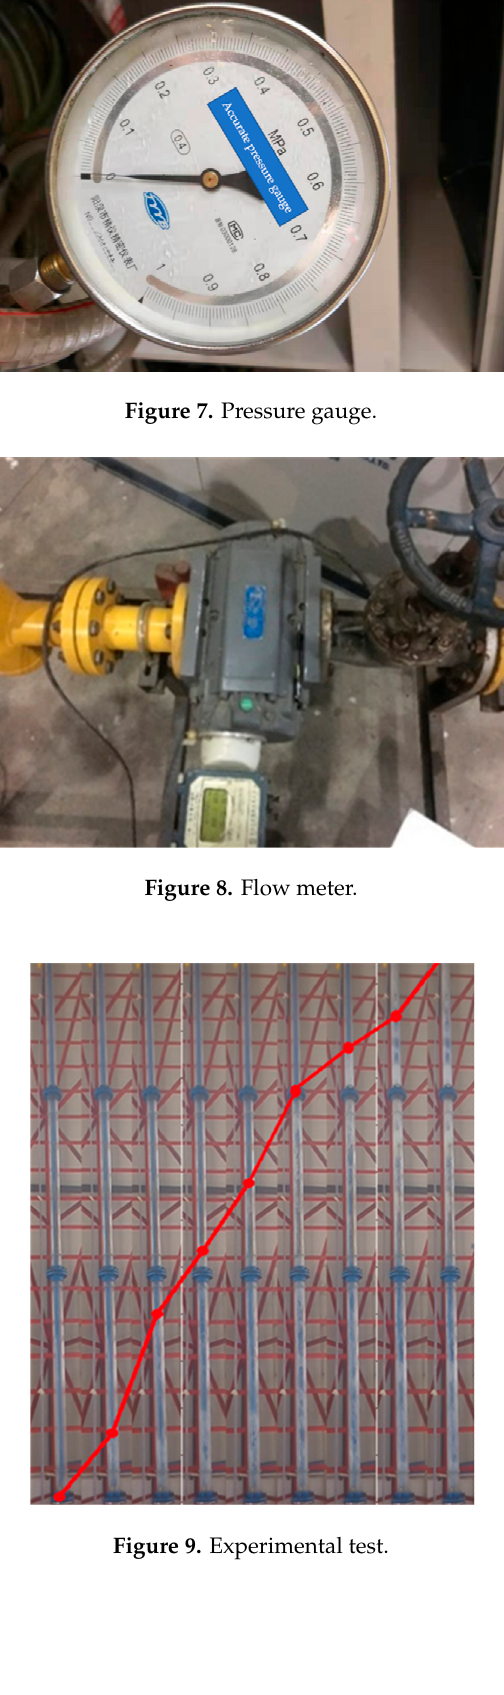
Figure 9. Experimental